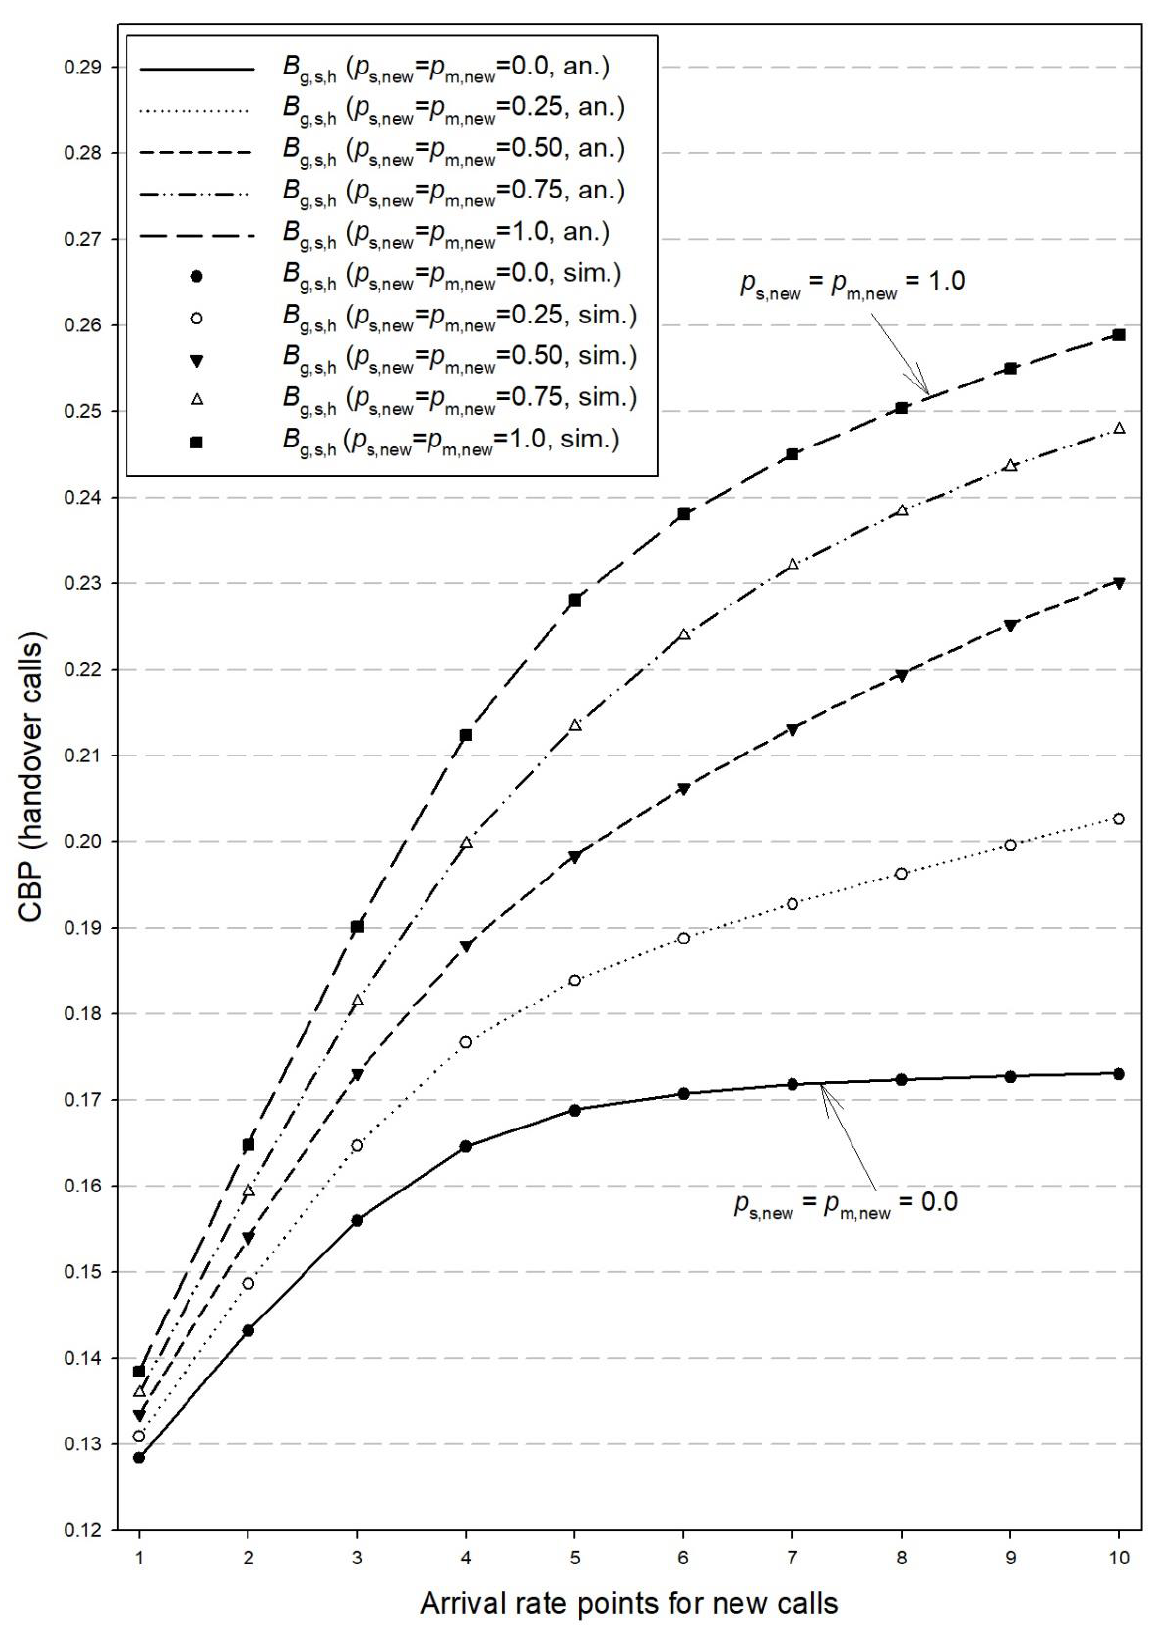
Figure 4. CBP of handover calls (in the stop phase) for different values of λ new .